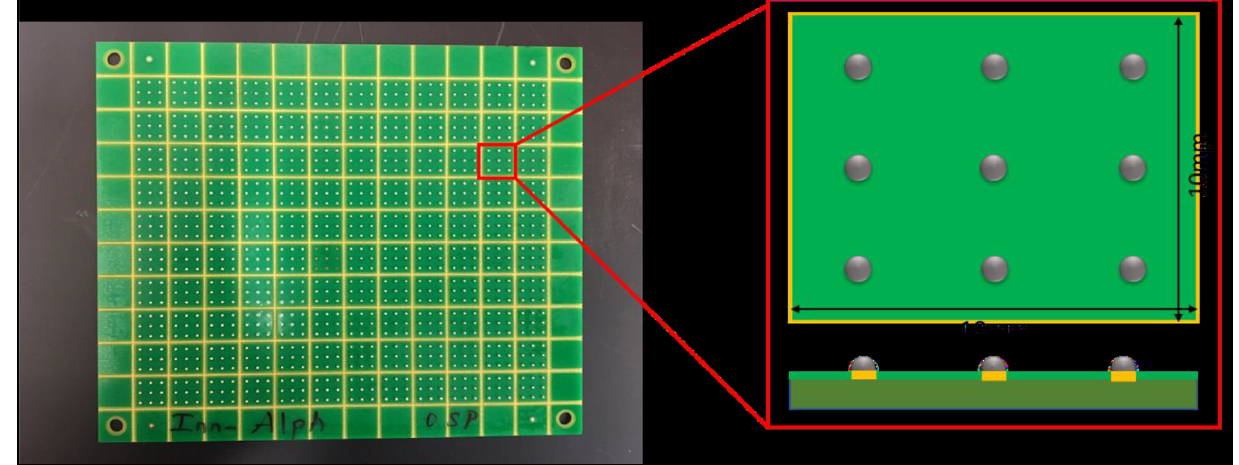
Figure 1. Test vehicle and individual solder joint.